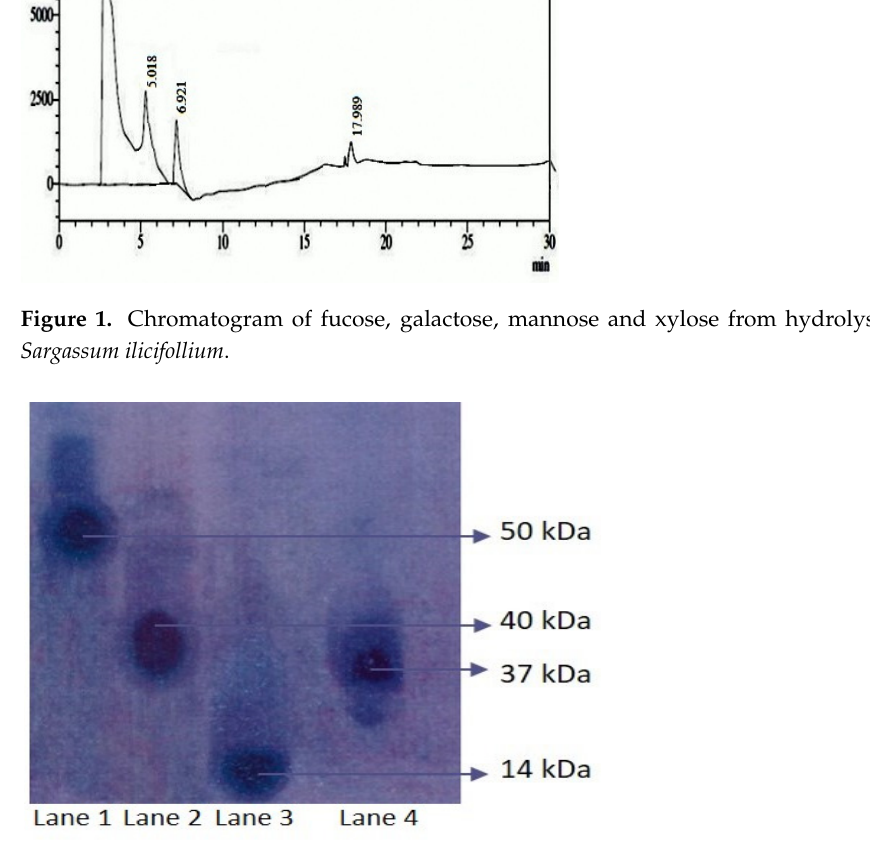
Figure Figure 2. Molecular weight Lane 1—Chondrioitin sulphate; Lane 2—Dextran sulphate; Lane 3— Heparan sulphate; Lane 4—Fucoidan.